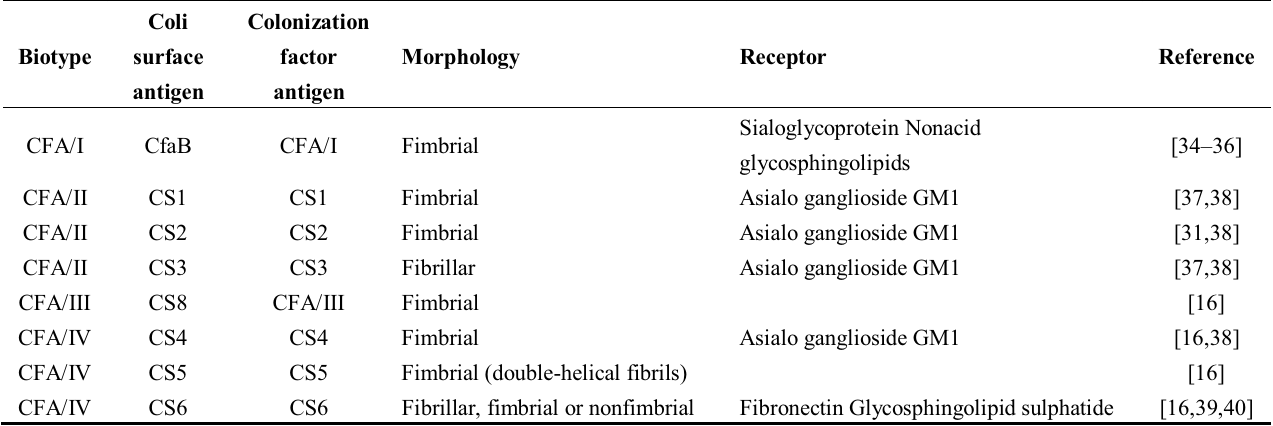
Table 2. Characteristics of colonization factors commonly detected in human-isolated ETEC